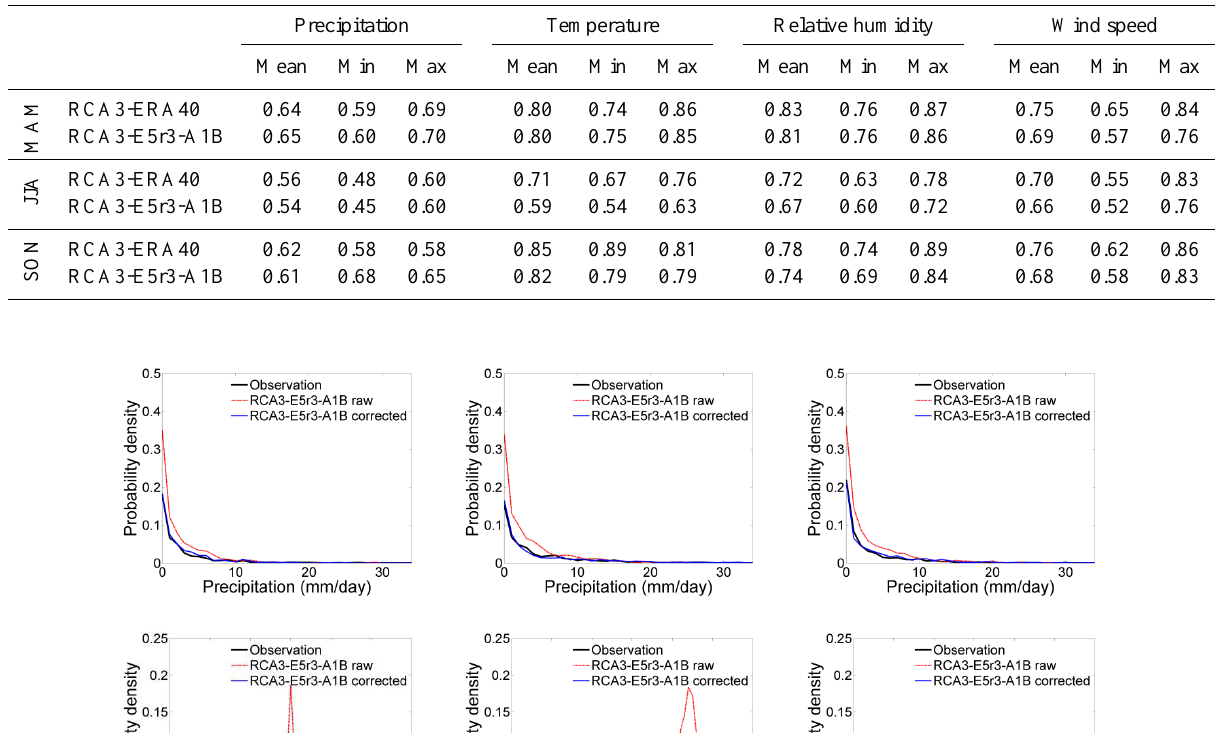
Table 3. PDF skill scores (SS) of raw data from RCA3-ERA40 and RCA3-E5r3-A1B (1966–1985), averaged over 14 Swedish stations.